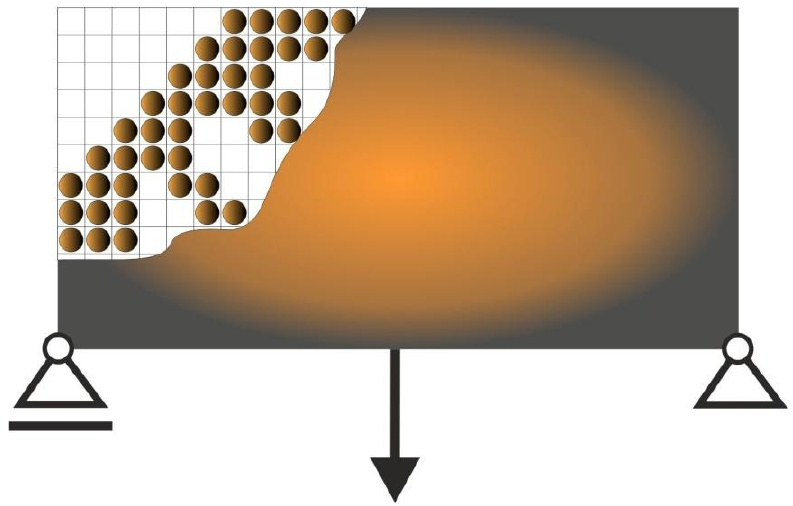
Figure 3. The topology generation. Some cells remain, some are eliminated.